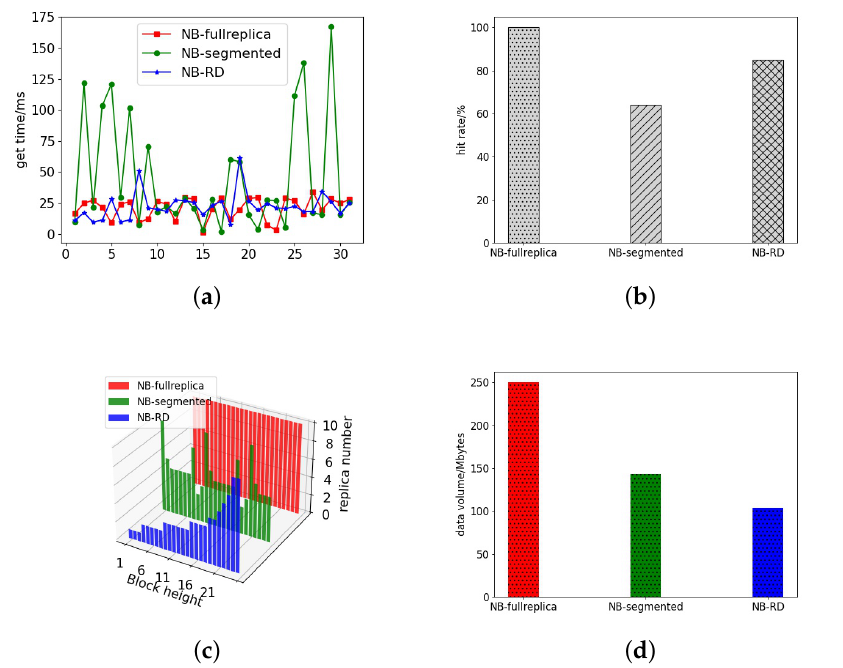
Figure 16. Simulation time = 20,000 s. ( a ) Data acquisition time. ( b ) Access hit rate. ( c ) Block replica number. ( d ) Replica data